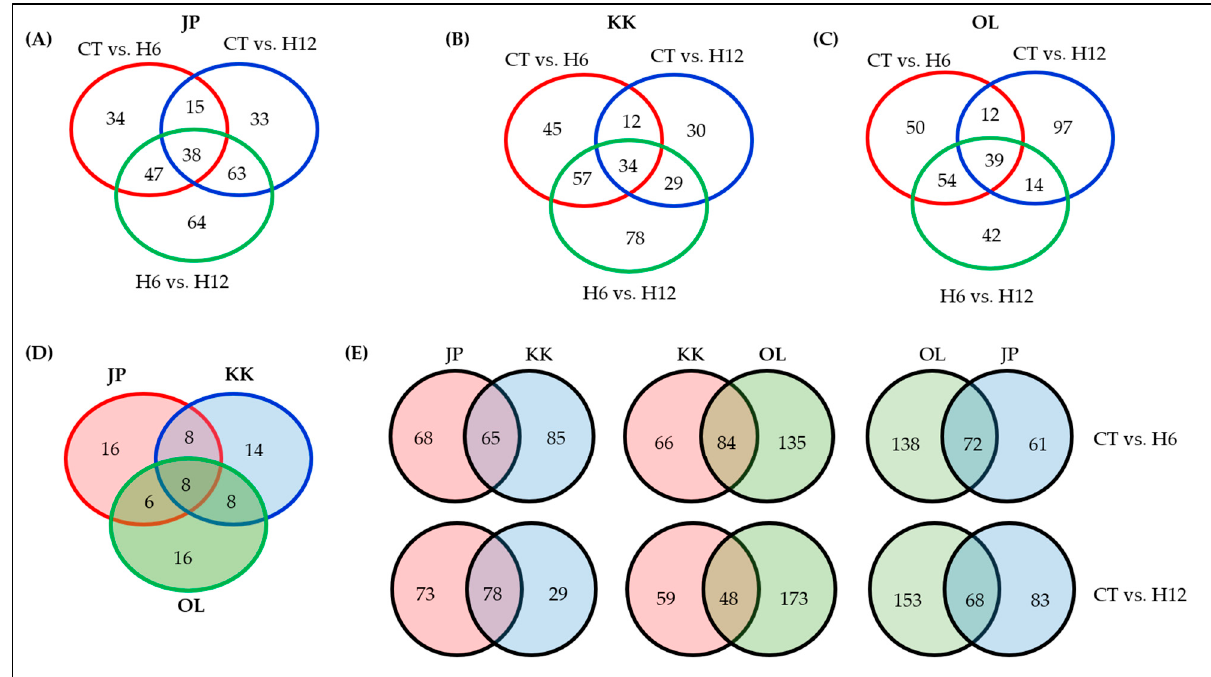
Figure 4. Venn diagram analysis of shared and specific genes across treatments and cultivars. ( A – C ) differentially-expressed genes (DEGs) of CT vs. H6, CT vs. H12, and H6 vs. H12 in Jopum ( A ), Keumkang ( B ), and Olgeuru ( C ). ( D ) DEGs of the three comparisons in Jopum, Keumkang, and Olgeuru. ( E ) DEGs between two combinations of JP, KK, and OL cultivars. CT, untreated control; H6, 6 h heat treatment; H12, 12 h heat treatment; JP, Jopum; KK, Keumkang; OL, Olgeuru.